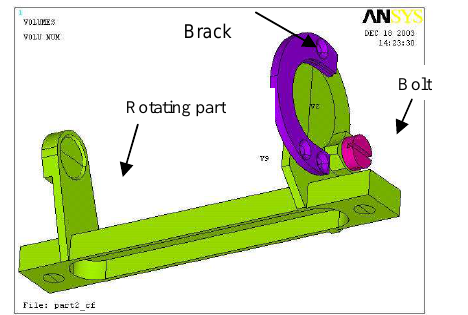
Fig. 4. Subassembly ‘B’, Fixed to Solar Panel.